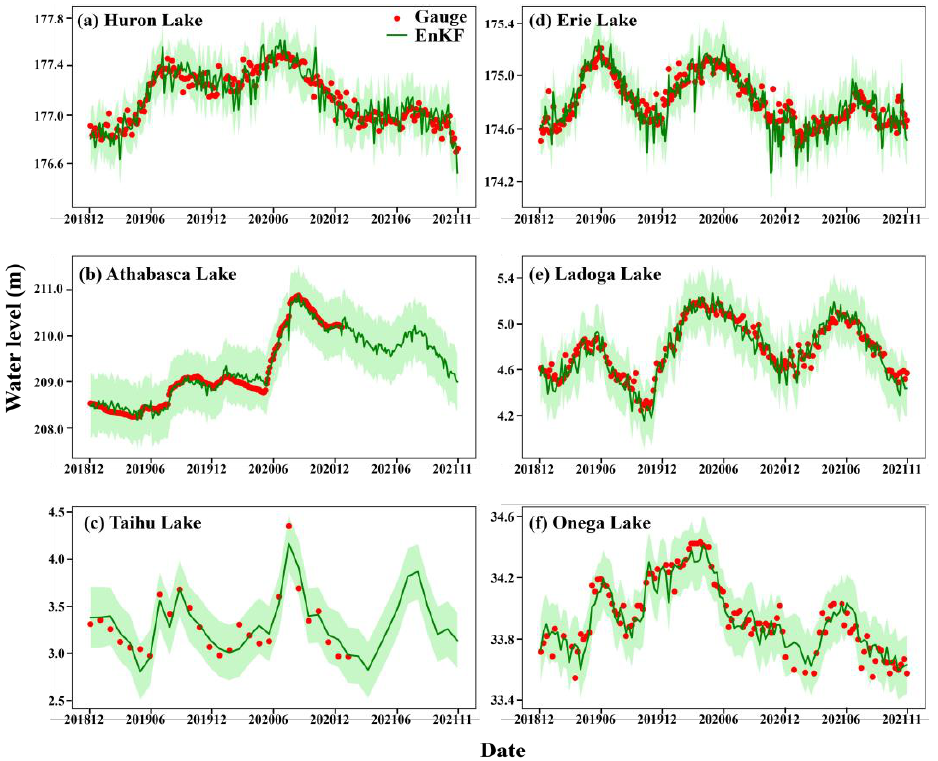
Figure 3. Comparison of optimized ICESat-2 and gauge-derived water level time series for the six validated lakes including ( a ) Huron Lake, ( b ) Athabasca Lake, ( c ) Taihu Lake, ( d ) Erie Lake, ( e ) Ladoga Lake, and ( f ) Onega Lake. The orthometric ICESat-2 water level time series based on EGM2008 is shifted to the individual reported water level height of the gauge data. Table 1. Assessment on the final processed water level results for the validated lakes.